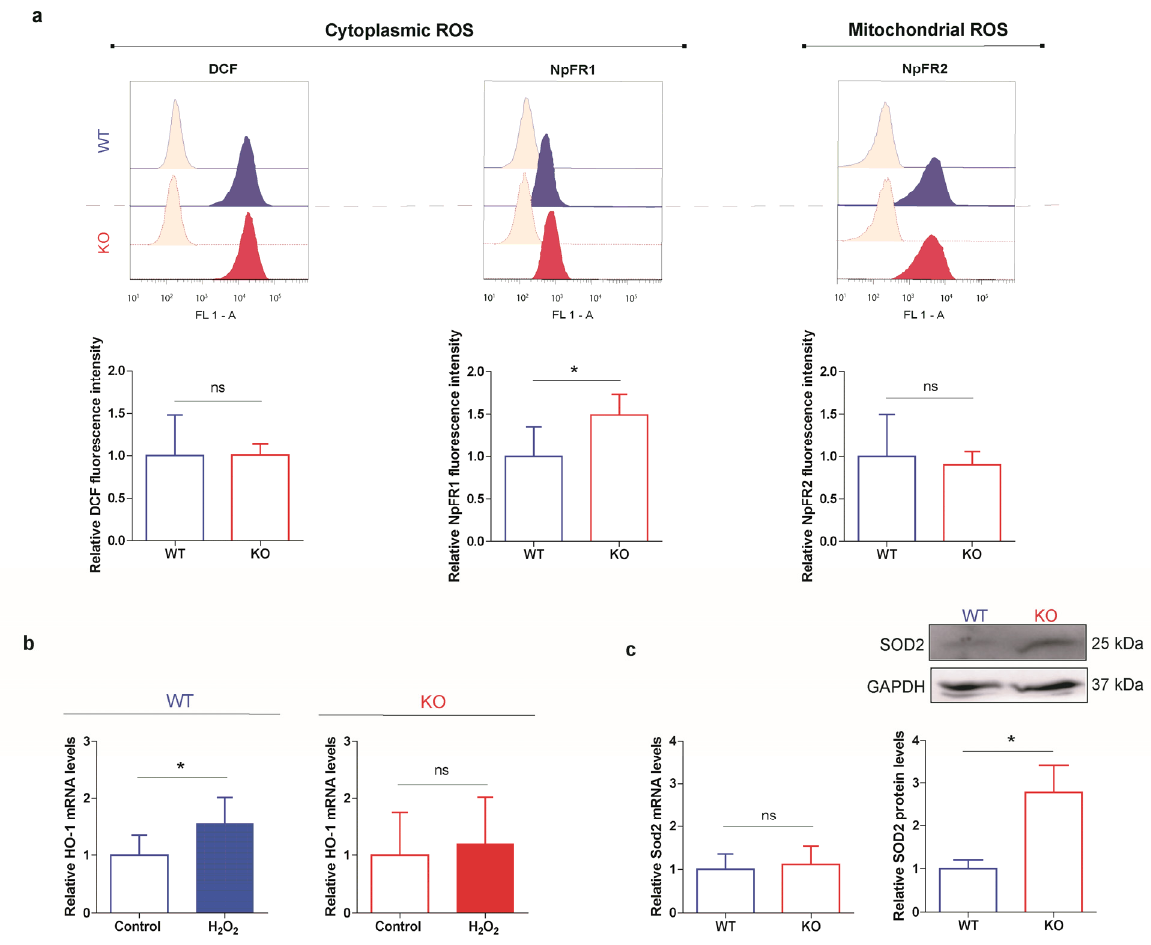
Figure 6. HO-1 is not induced in oxidant conditions in p53 KO ES cells consistent with an adapted stress response. WT and p53 KO ES cells were cultured under standard conditions. ( a ) ROS levels were measured by flow cytometry with H2DCF-DA, NpFR2 and NpFR1 probes. Upper panels show representative histograms and lower panels show the relative fluorescence intensity for each probe. Bars represent the mean ± SEM of three independent experiments. ( b ) WT and KO ES cells were treated with 100 μ M H 2 O 2 during 4 h and HO-1 mRNA levels were analyzed by RT-qPCR. Bars represent the mean ± SEM of four independent experiments. ( c ) Sod2 mRNA and protein levels were analyzed by RT-qPCR and Western blot, respectively. In RT-qPCR HO-1 or Sod2 levels were normalized to the housekeeping gene Gapdh and referred to the corresponding control (untreated control for ( b ), WT ES cell line for ( c )). In Western blots GAPDH was used as loading control. Bars represent the mean ± SEM of three independent experiments. Asterisks indicate significant differences when comparing to the corresponding control condition (*, p < 0.05).